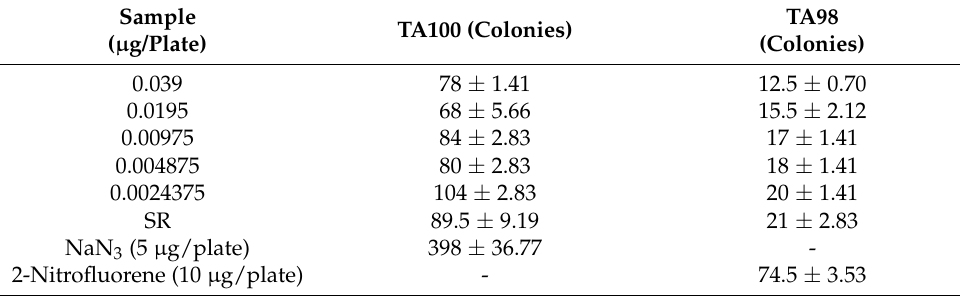
Table 1. Revertant colonies obtained in the Ames test of AgNPs.